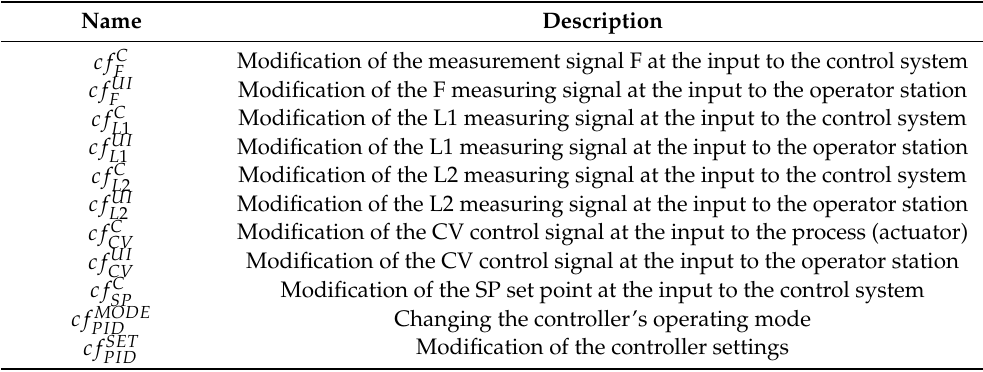
Table 3. The set of